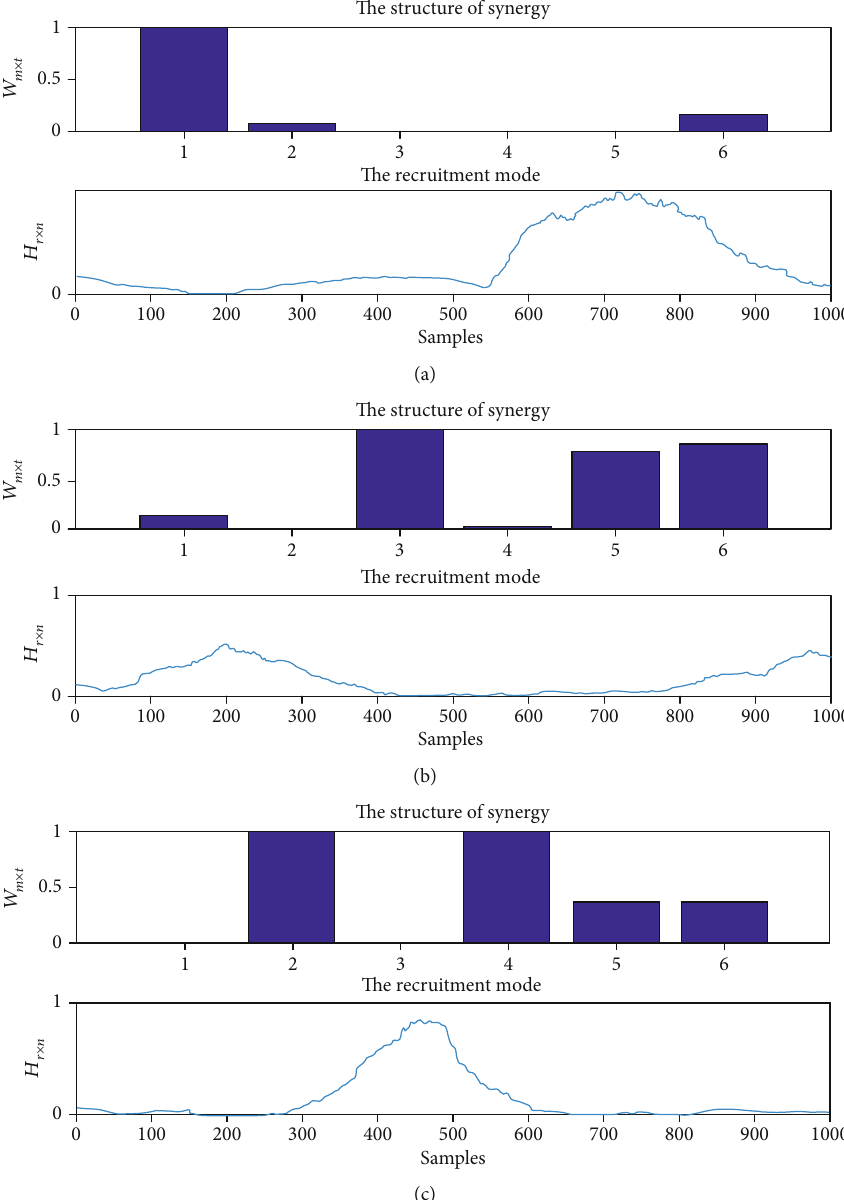
Figure 5: The typical results of muscle synergies of upper limbs for healthy subjects during the HRI with counterclockwise circle-drawing movements. (a) The synergy pattern and activation coe ffi cients for the fi rst synergy; (b) the synergy pattern and activation coe ffi cients for the second synergy; (c) the synergy pattern and activation coe ffi cients for the third synergy. The structure of synergy represents the synergy pattern of muscle synergies, and the recruitment mode represents the activation coe ffi cients of muscle